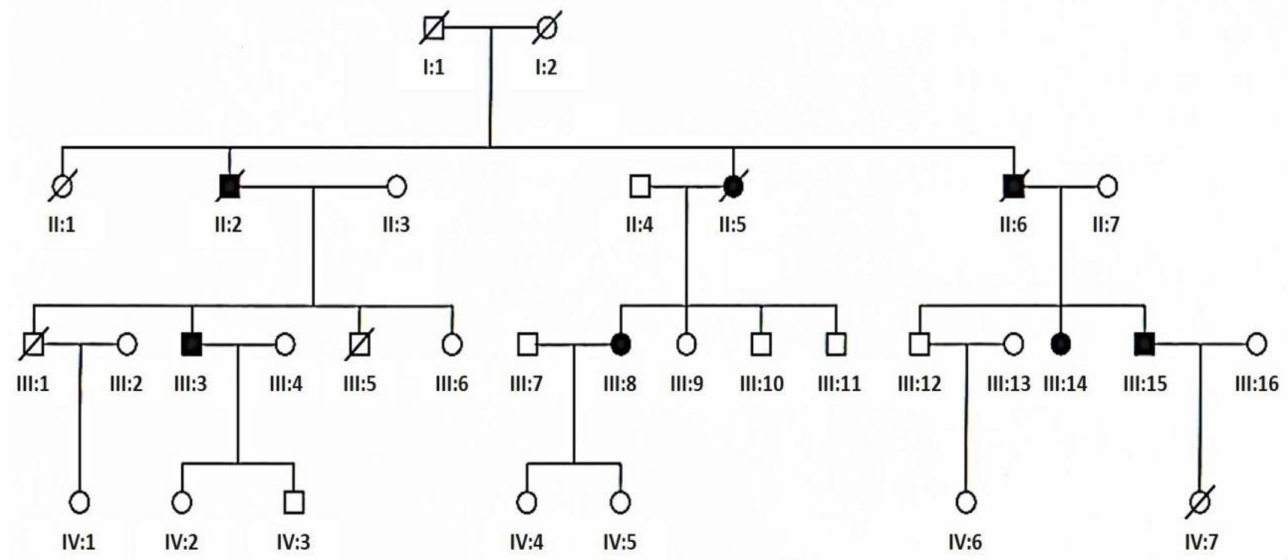
Figure 2. Pedigree of family with TWNK mutation (empty circle—female, empty square—male, solid circle—affected female, solid square—affected male, slashed circle—deceased female, slashed square—deceased male, slashed solid circle—deceased affected female, slashed solid square—deceased affected